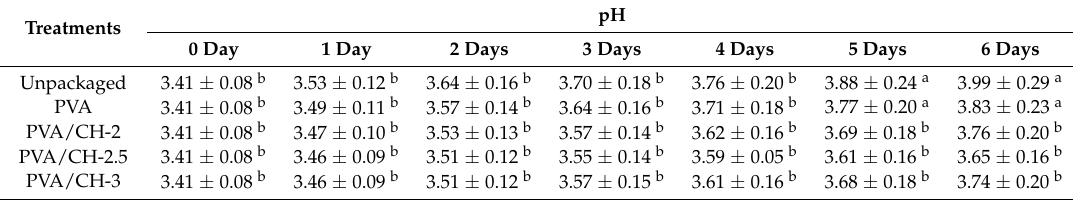
Table 3. pH analysis of strawberries treated with different films during